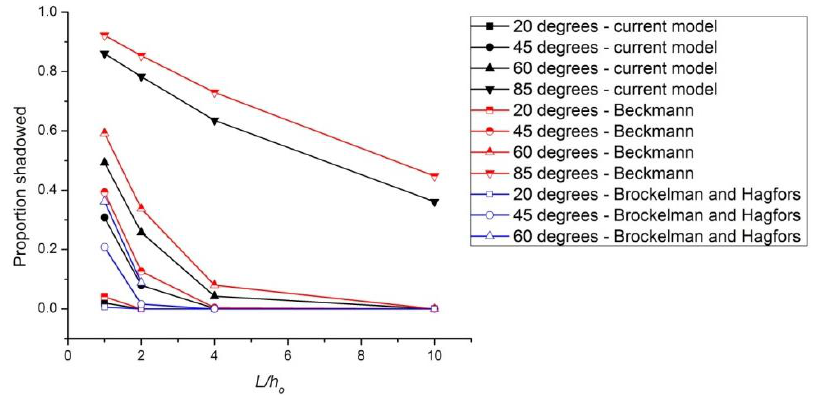
Figure 4. Comparison of the surface shadowing results in Figure 3 to those produced by the shadowing functions derived by Brockelman and Hagfors and by Beckmann. Data from both historical models is taken from reference